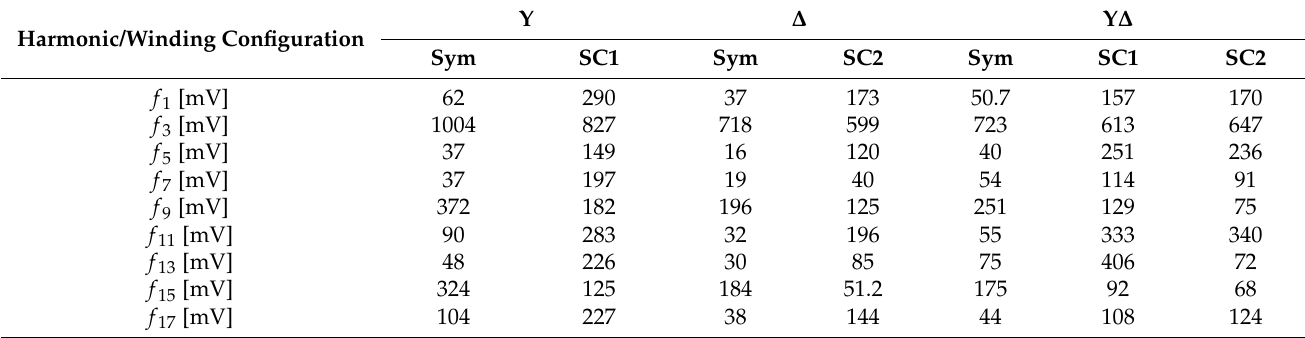
Table 7. FFT of u 0 —laboratory